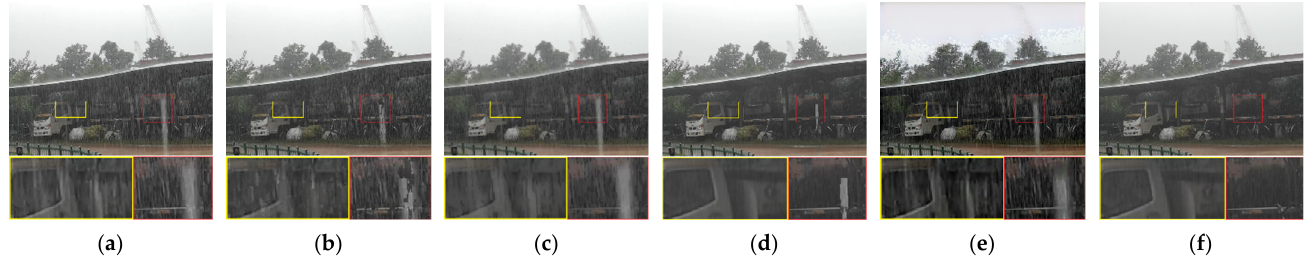
Figure 9. Comparison on a real rain video. ( a ) Input, ( b ) Kim et al. [16], ( c ) Wang et al. [8], ( d ) Li et al. [14], ( e ) Chen et al. [32], ( f ) proposed method.